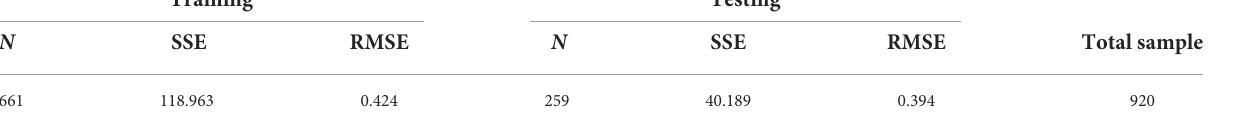
FIGURE6 ANN sketch for COVID.